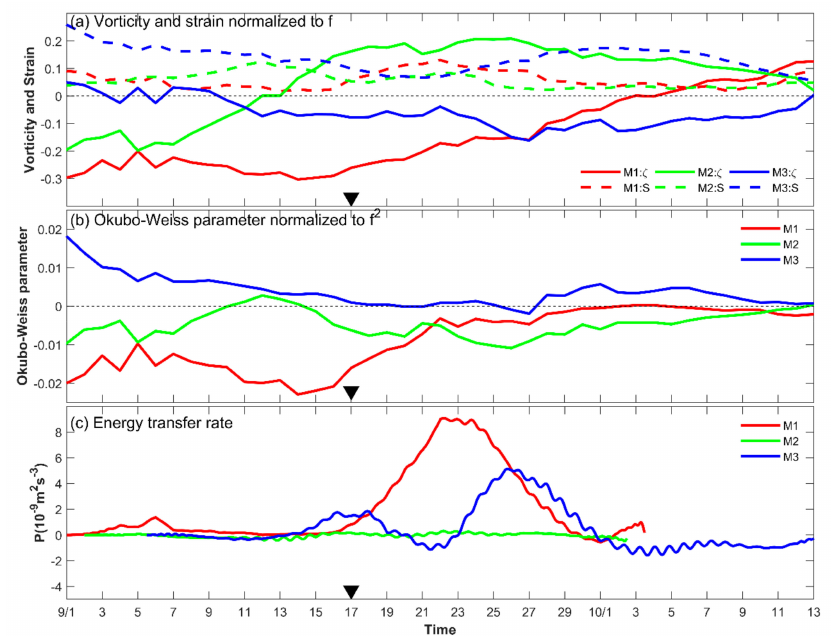
Figure 11. Evolution of ( a ) vorticity ( ζ ) and strain (S) normalized to inertial frequency ( f ), ( b ) Okubo– Weiss parameter normalized to f 2 , and ( c ) depth-mean energy transfer rate from mesoscale field to NIWs. The approach time of typhoon Noul is denoted by the black